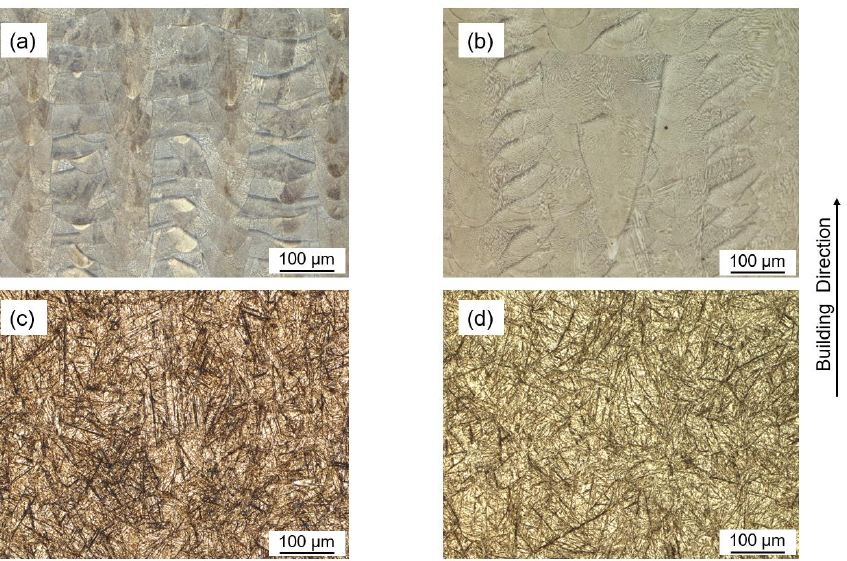
Figure 5. Optical micrographs: ( a ) as-built with a preheating of 250 °C; ( b ) as-built with a preheating of 500 °C; ( c ) conventional heat treatment; ( d ) HIP integrated with quenching and tempering. Carbides can be observed with higher magnification by SEM. Figure 6a shows the